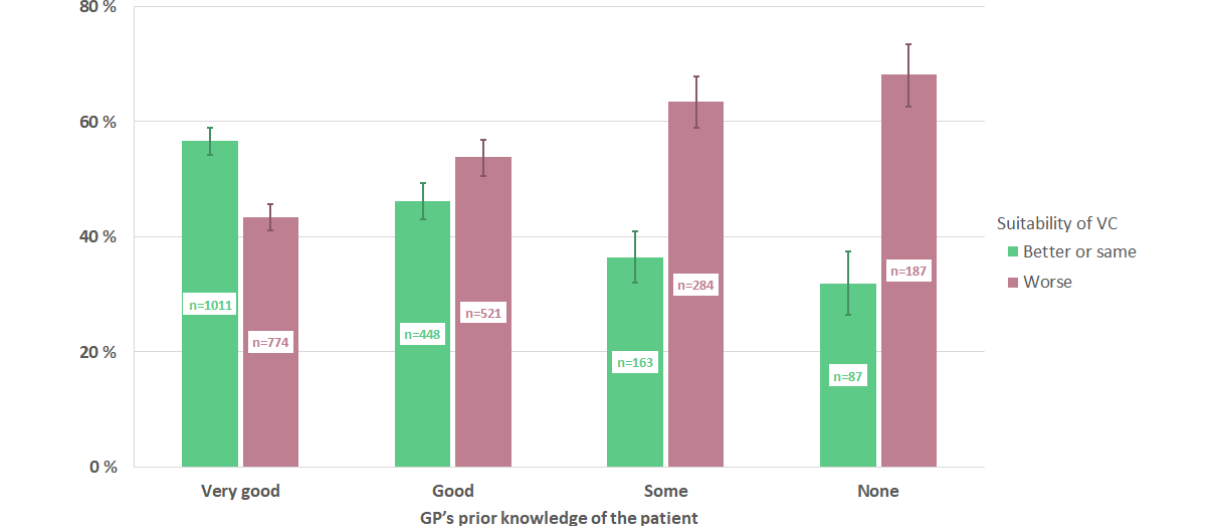
Figure 1. Association between relational continuity (previous knowledge of the patient) and general practitioners' perceived suitability of video consultations compared to an envisaged face-to-face consultation for the same issue (95% CIs are illustrated by lines). GP: general practitioner; VC: video